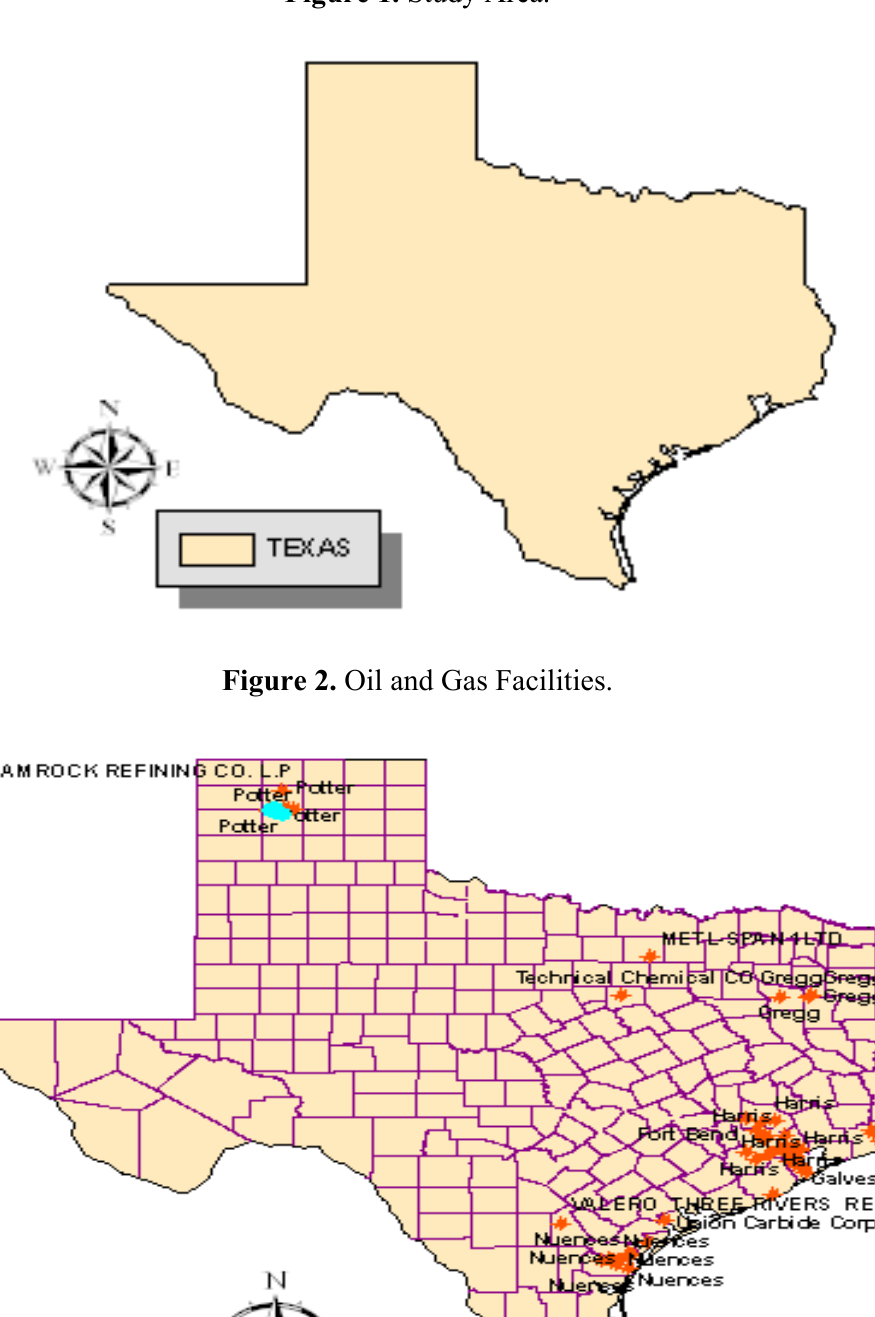
Figure 1. Study Area.